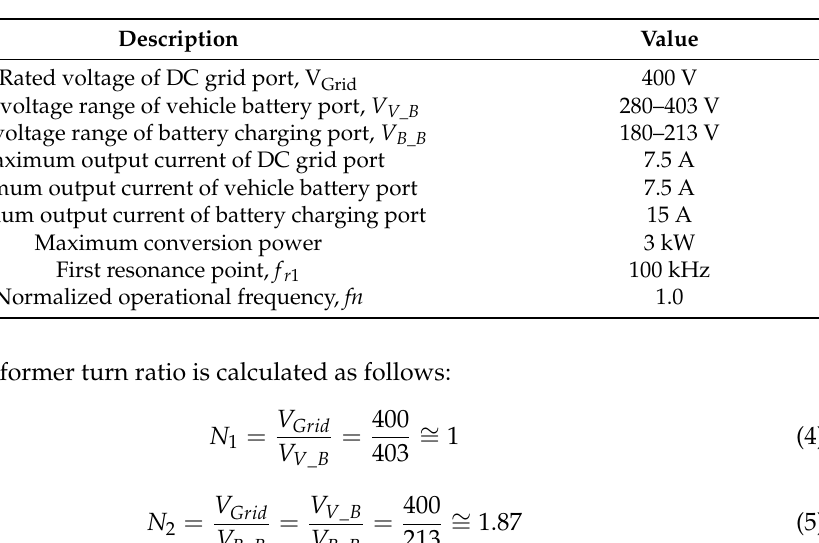
Table 2. Selected specifications of the